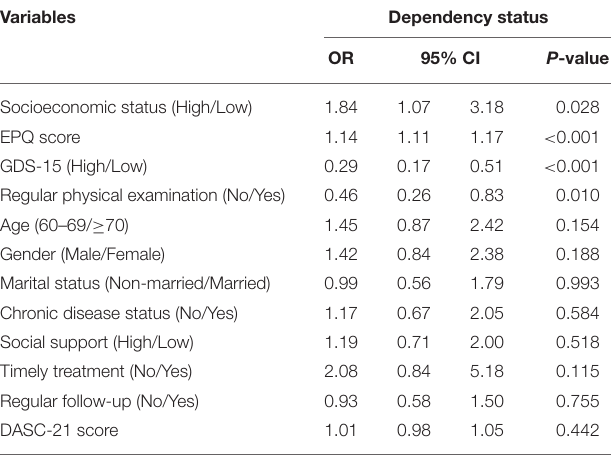
TABLE 3 | The odd ratios of socioeconomic status for dependency by logistic regression model.